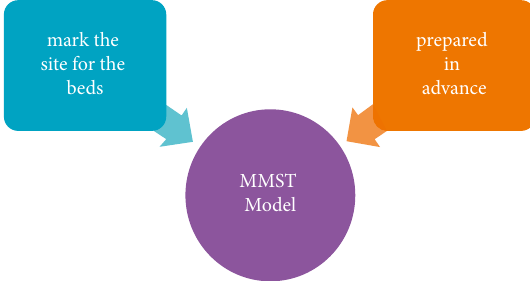
Figure 1: MMST warm bed preparation model.